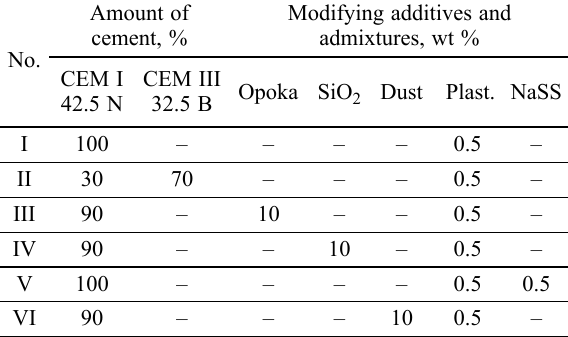
Table 1. Compositions of tested cement